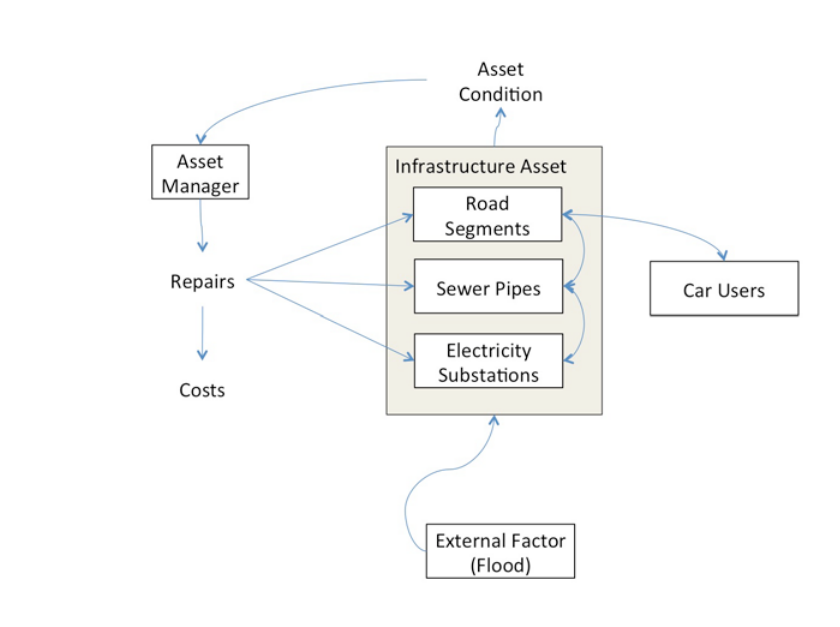
Figure 2. Schematic illustration of interconnectedness in assets, and its relation to users and owners Road Pavement Segments: We assume these will deteriorate by a constant unit of damage per day and that caused by each car user agents using that particular road segment. All road pavements are given same initial condition index, and the damage from car users causes a degradation of this